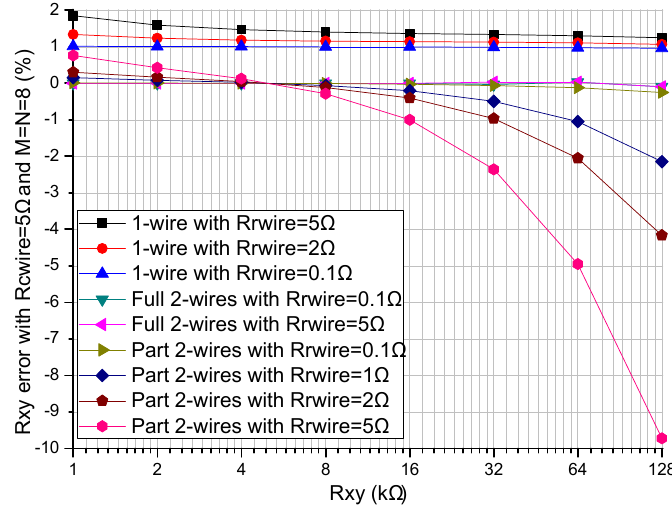
Figure 3. Effect of the R rwire on the R xy errors in the three circuits where R cwire = 5 Ω and M = N = 8.